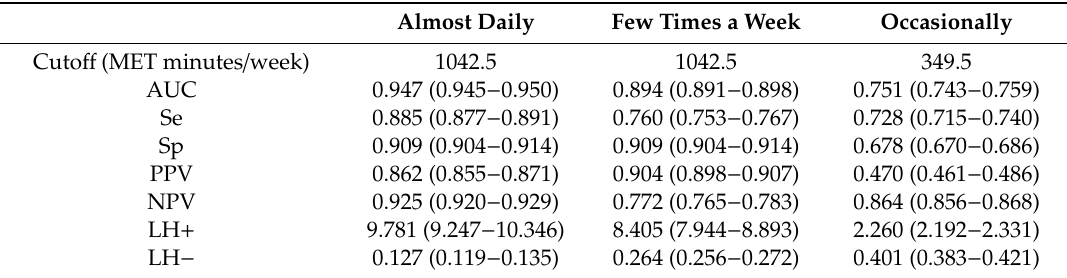
Table 1. Classification performance parameters with 95% confidence interval (CI) and cutoffs. Never group was the reference.